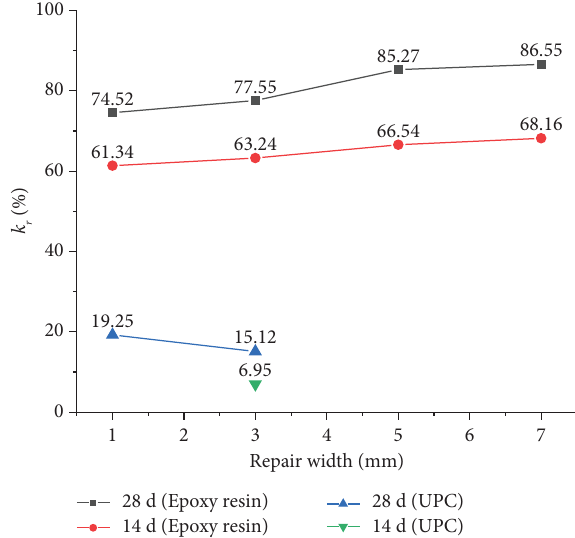
Figure 32: k r of epoxy resin and UPC for cracked rock with diferent repair widths and curing